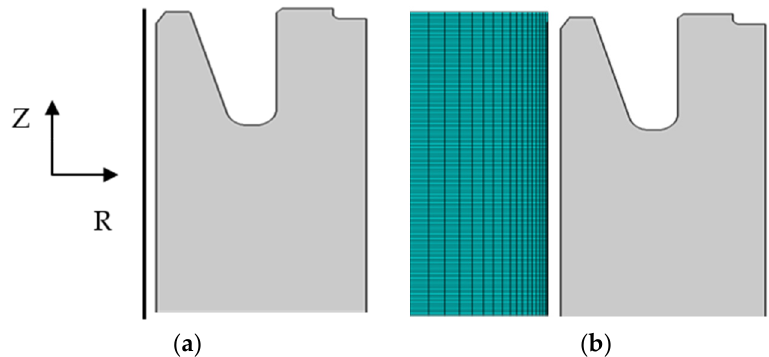
Figure 3. 2D axial symmetric geometry of gear blank and mandrel for two evaluated set-ups: ( a ) Mandrel as analytical rigid body. ( b ) Mandrel as solid body with elastic plastic properties.